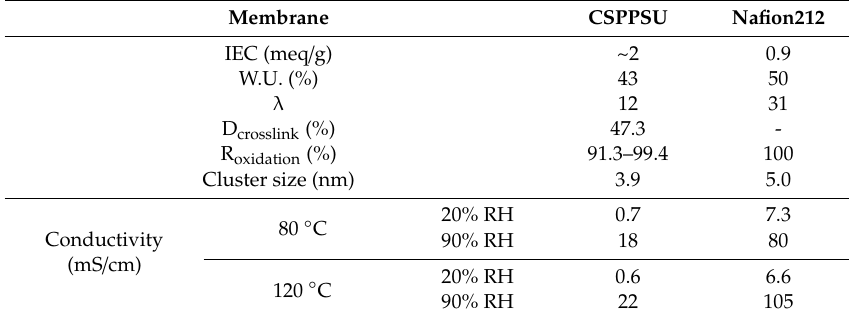
Table 2. Physicochemical and conductivity properties of CSPPSU and Nafion212